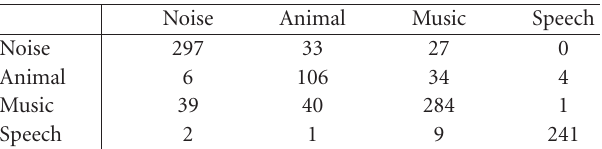
Table 2: Confusion matrix (rows give the decision and columns give the true class) for MFCC with GMM. This method gave an accuracy of 85.85%.